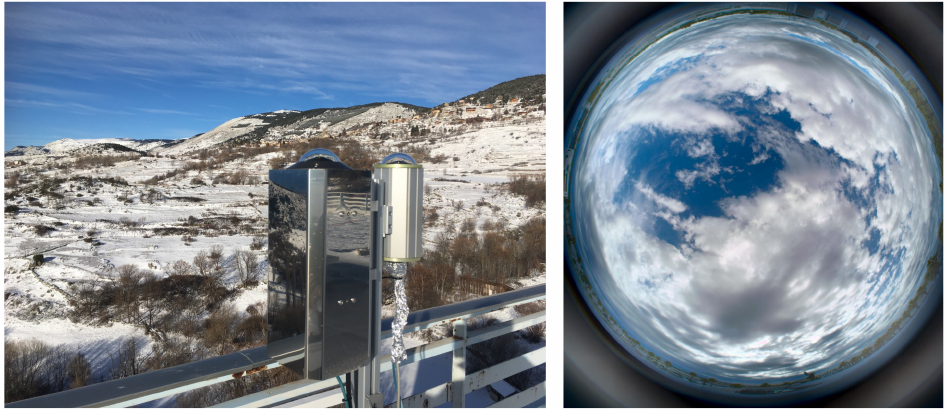
Figure 11. Left : The sky imager installed at the PROMES-CNRS laboratory in Odeillo (France). Right : A high-dynamic-range (HDR) sky image, without correction of the distortion.